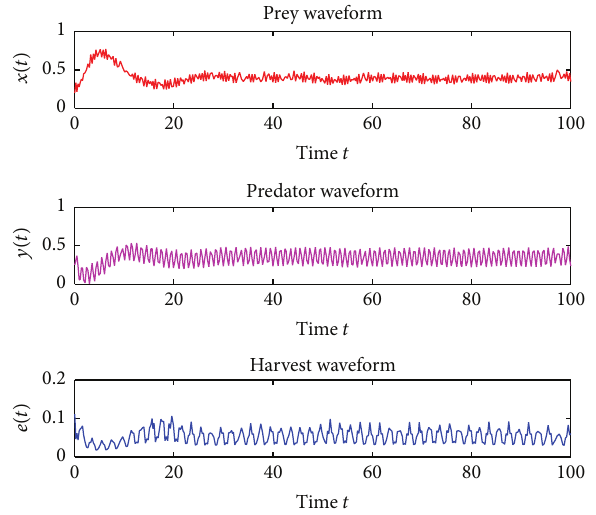
Figure 8: Oscillation solutions of stochastic system (9) in the case of 𝜏 = 2.960